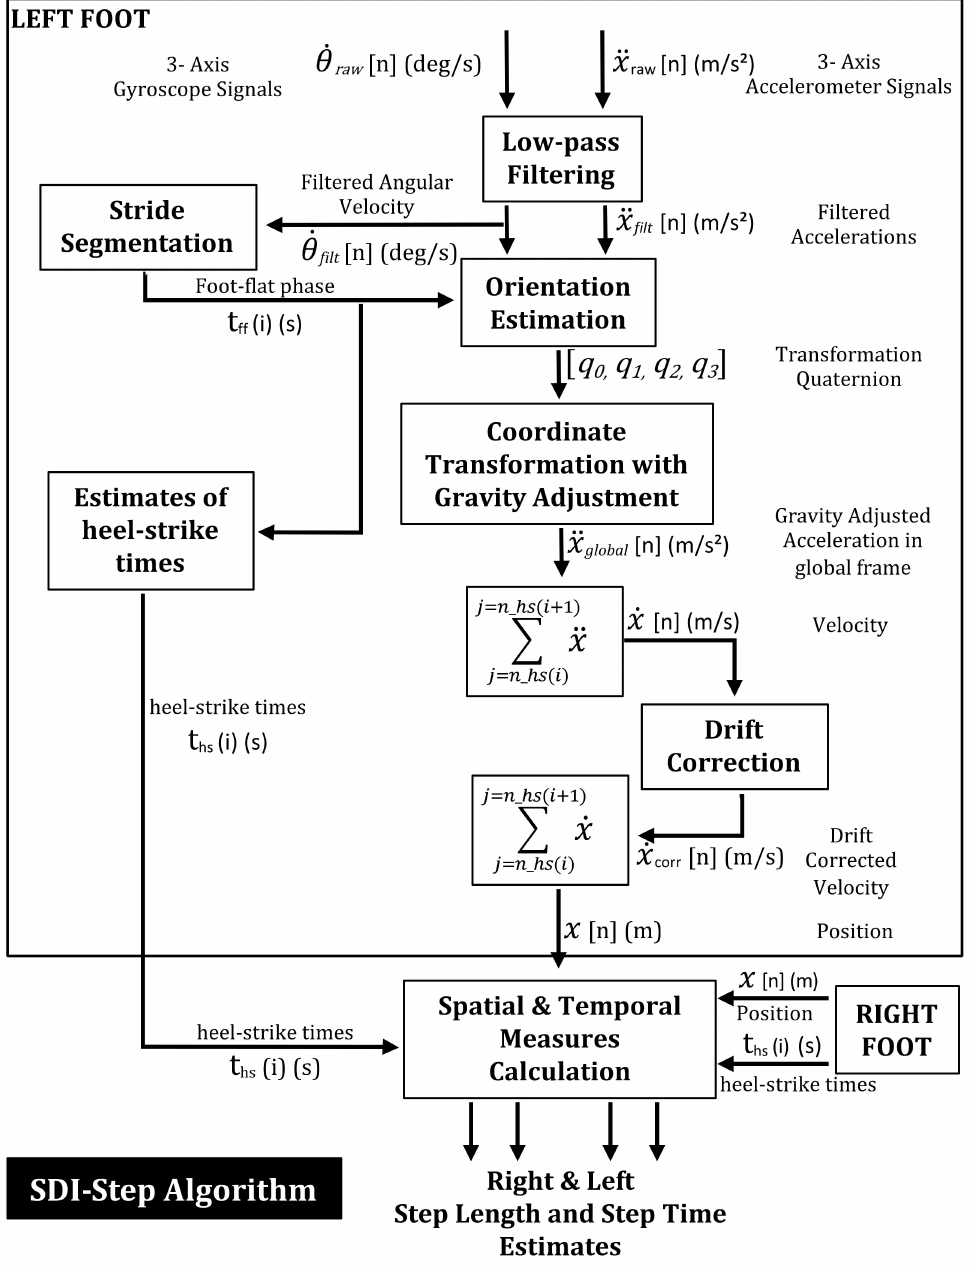
Figure 1. Flowchart depicting the computational modules involved in the Segmented Double Integration (SDI)-Step algorithm developed for an Inertial Measurement Unit (IMU)-based wearable gait measurement